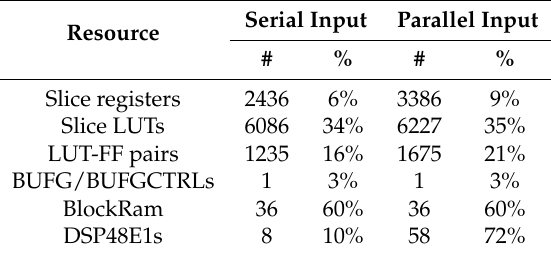
Table 6. Comparison of resources